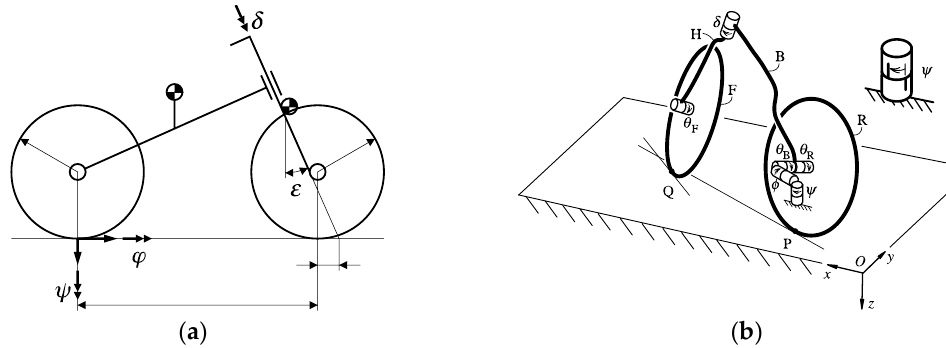
Figure 1. The low dimensional Whipple/Carvallo bicycle model with coordinates and main dimensions; ( a ) side view with rear frame roll angle  , rear frame yaw angle ψ , front frame to rear frame steer angle δ , wheelbase w , front wheel trail c , and head angle ε , ( b ) 3D position and orientation of the bicycle model in the space fixed O-xyz coordinate system, with rear and front wheel contact points P and Q, figures from [13] and